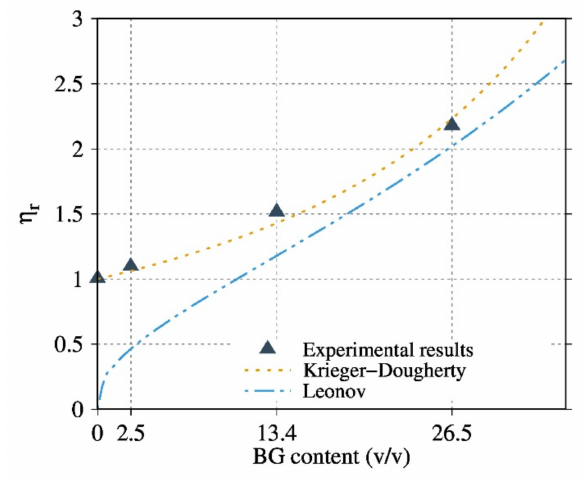
Figure 10. Relative viscosities or hydrodynamic interaction versus the BG volume percentage for composites of PP filled with BG 0.04–0.5 mm T3. Comparison between the experimental values of the relative viscosities calculated from the real M w values and the theoretical relative viscosities calculated from the Krieger-Dougherty and Leonov models.